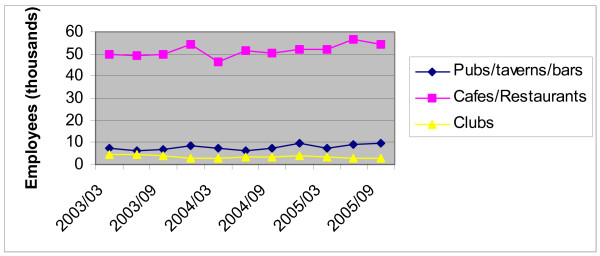
Employment in licensed premises, restaurants and cafés 2003–2005 (in full-time equivalents). National data from Statistics New Zealand [8].